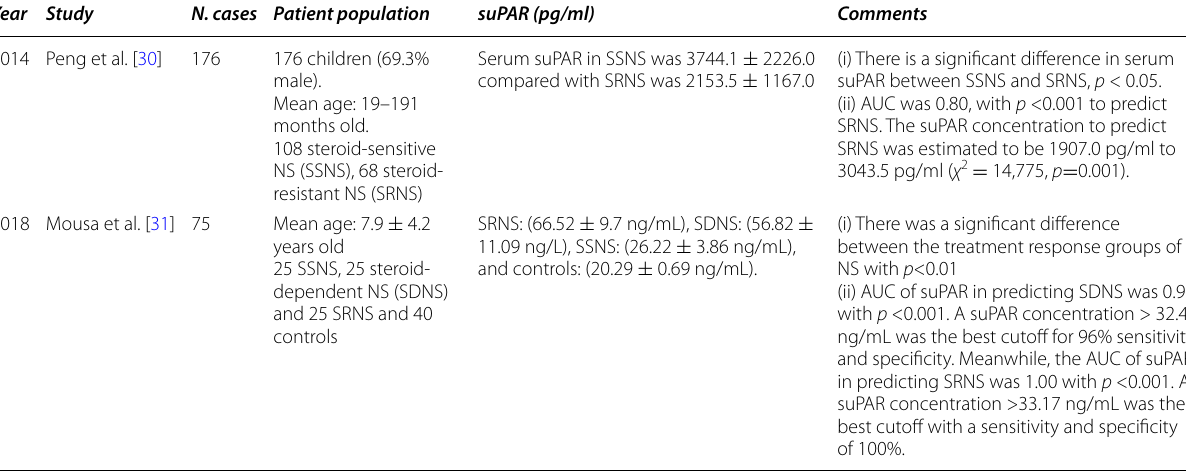
Table 3 Summary of studies on suPAR related to treatment response in nephrotic syndrome Year